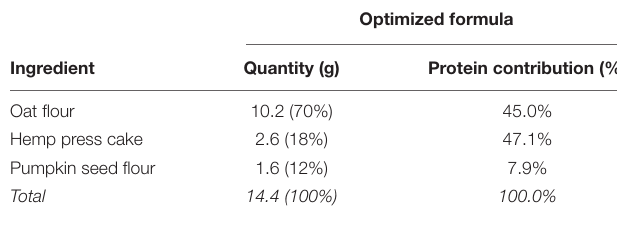
TABLE 4 | Optimized mixture for oat